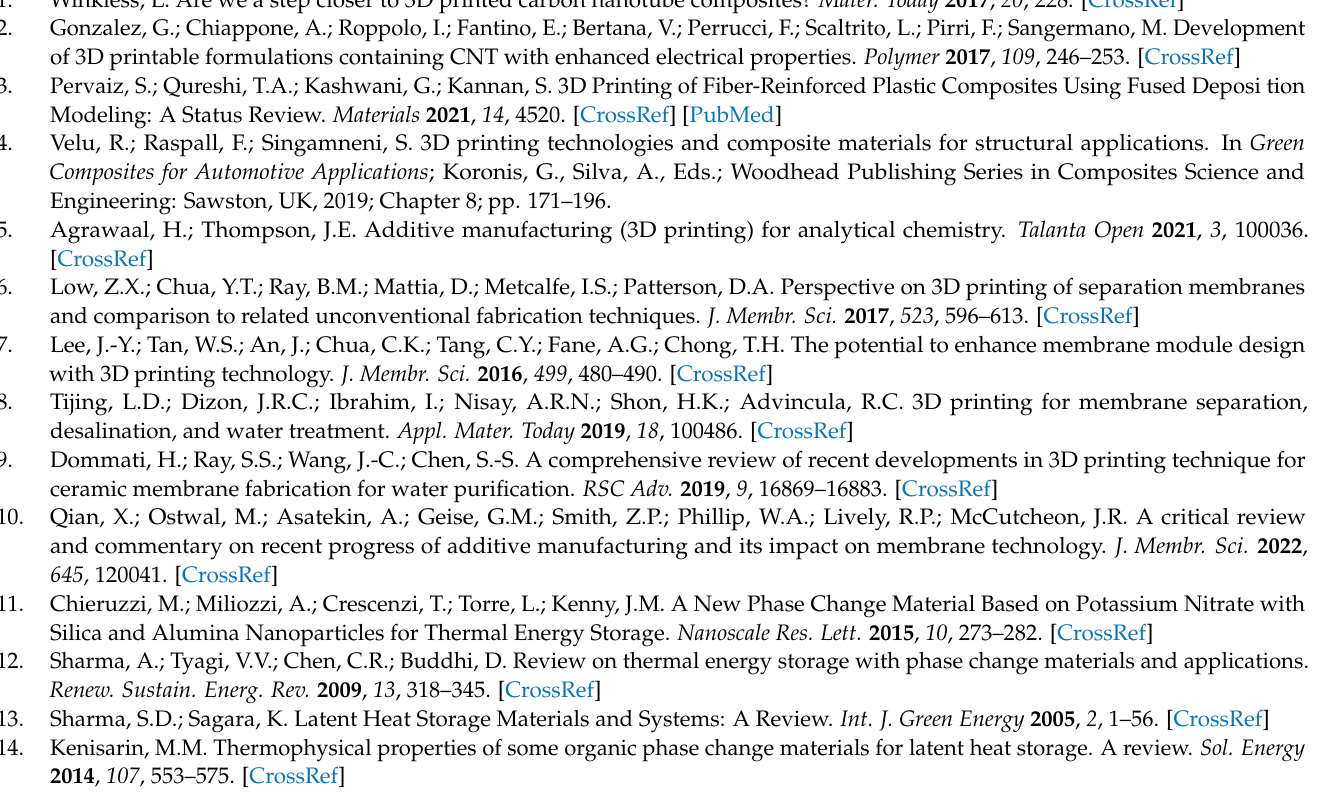
Figure S2: DSC results of NaNO 3 impregnated 3D structure.; Figure S3. DSC results of KNO 3 impregnated 3D structure.; Figure S4. DSC results of NaNO 3 -KNO 3 impregnated 3D